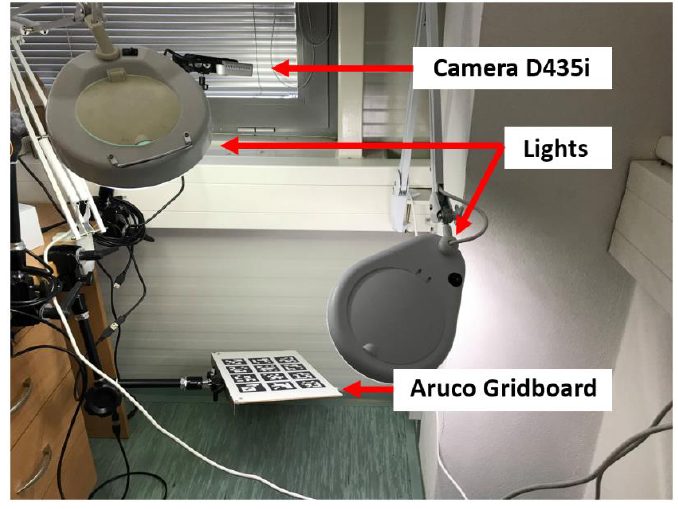
Figure 1. Calibration process.